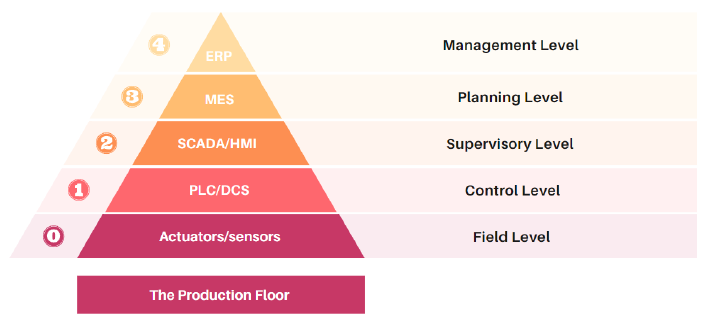
Figure 1. The ISA-95 automation pyramid (adapted from